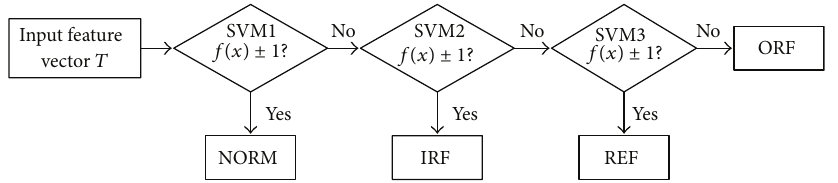
Figure 7: Structure diagram of SVM based multifault classifier.